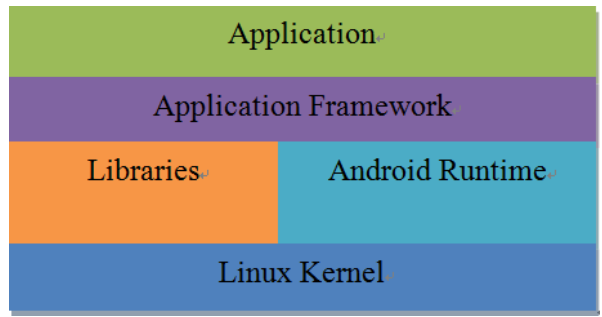
Figure 4. The architecture of Android